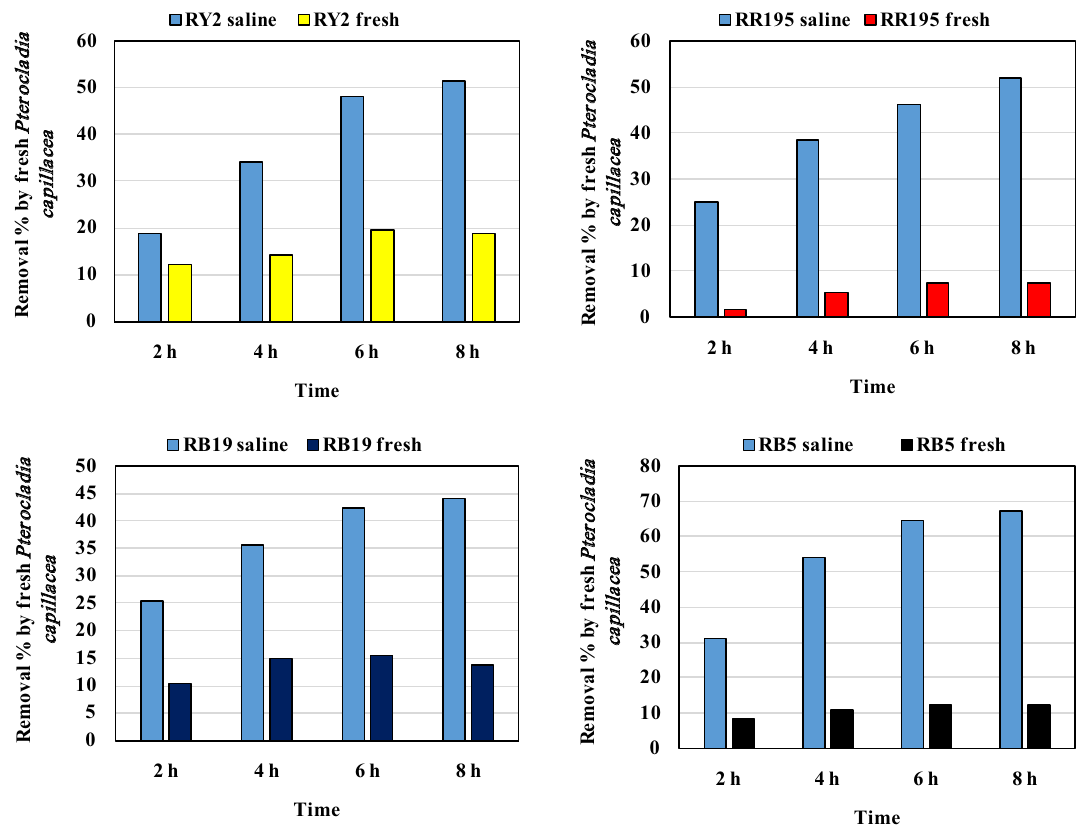
Fig. 10 Removal percentages of the four studied dyes by fresh Pterocladia capillacea under saline and fresh conditions Table 11 Removal percentages of the four studied dyes by dried Ulva fasciata under saline and fresh